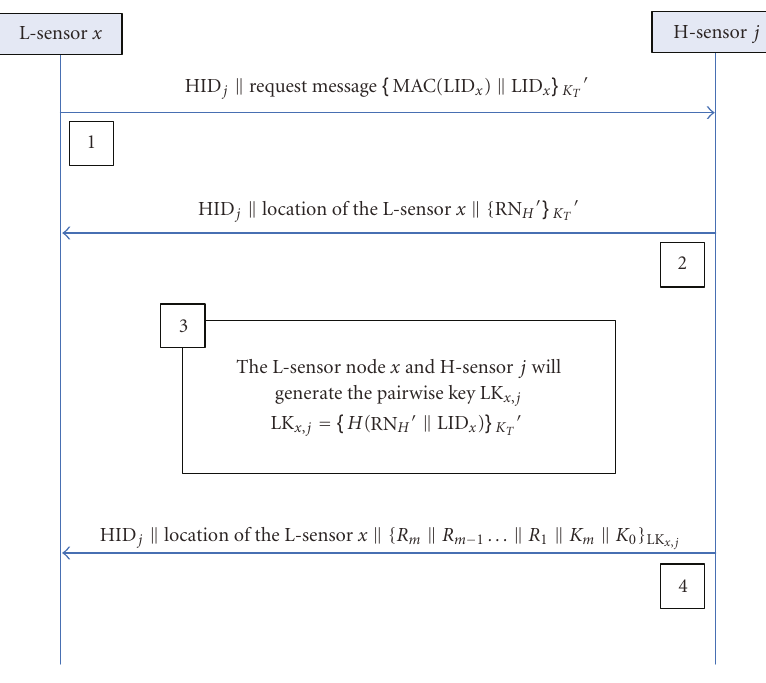
Figure 5: A pairwise key established between the node x and H-sensor j